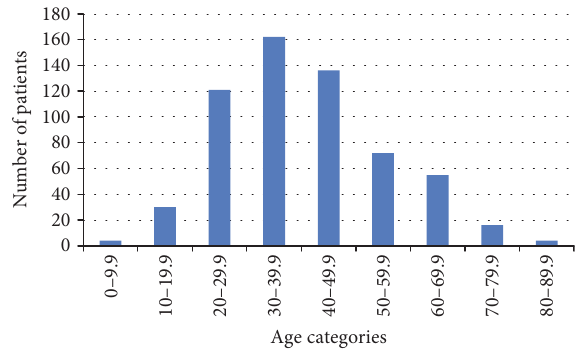
Figure 1: Age distribution of 600 cases of di ff erentiated thyroid cancer seen during the period 2004-2005.